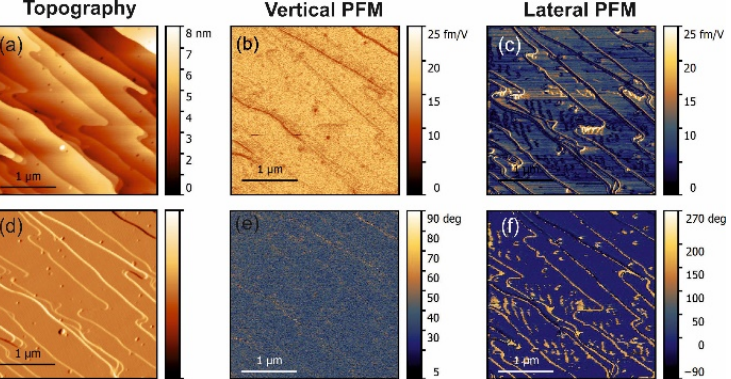
Figure 1. PFM measurements in undoped glycine. ( a ) Topography and ( c ) deflection; ( b ) amplitude and ( d ) phase of the vertical piezoresponse. The lateral PFM was null because no resonance could be excited.